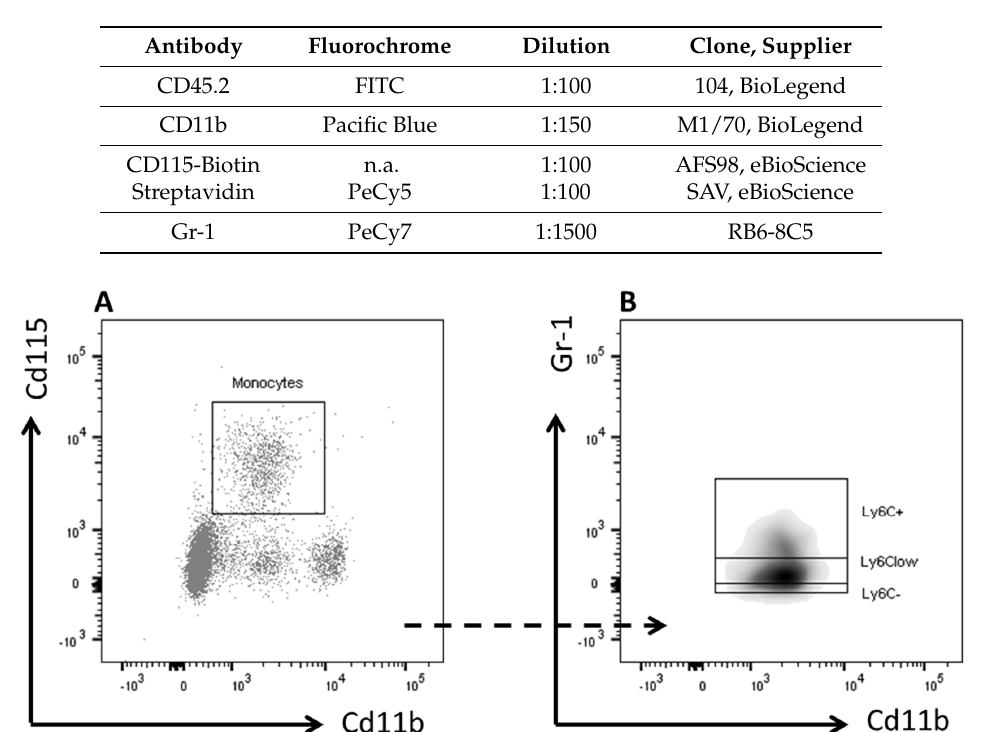
Figure 1. Gating strategy. Gating strategies for the analysis of ( A ) granulocytes, total monocytes, and ( B ) Ly6C + , Ly6C low , and Ly6C ‐ monocyte subsets in whole blood.